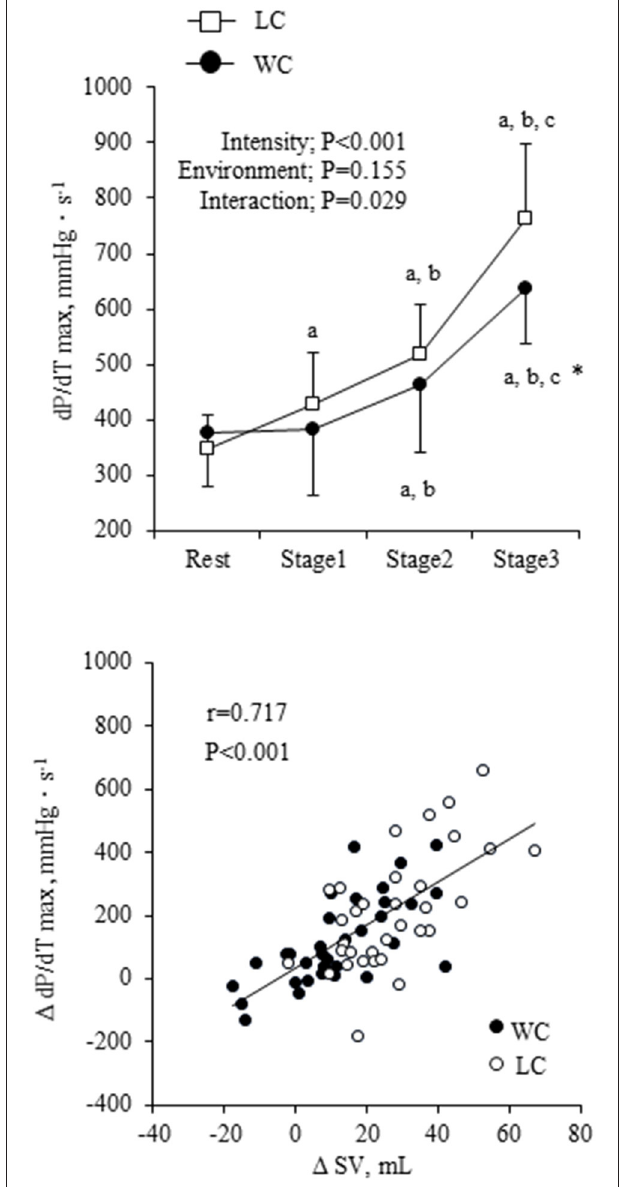
FIGURE 4 | The maximum rate of aortic pressure rise (dP/dT max ) response at rest and during exercise and scatter plot of change in SV in responses to changes in dP/dT max . Filled circles indicate the change in WC condition, and open squares and circles indicate the change in LC condition. a,b,c show significant differences from rest, stage 1, and stage 2 of the same environment, respectively. *indicates a significant difference from land at the same